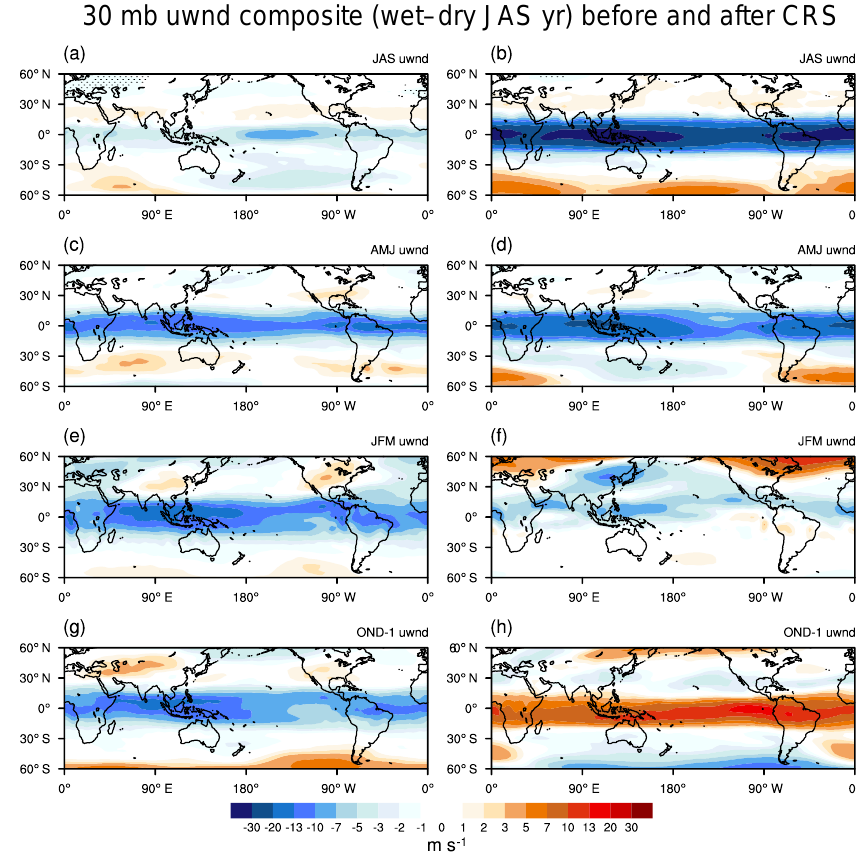
Figure 10. As in Fig. 8 but for 30mb zonal wind (uwnd) anomaly